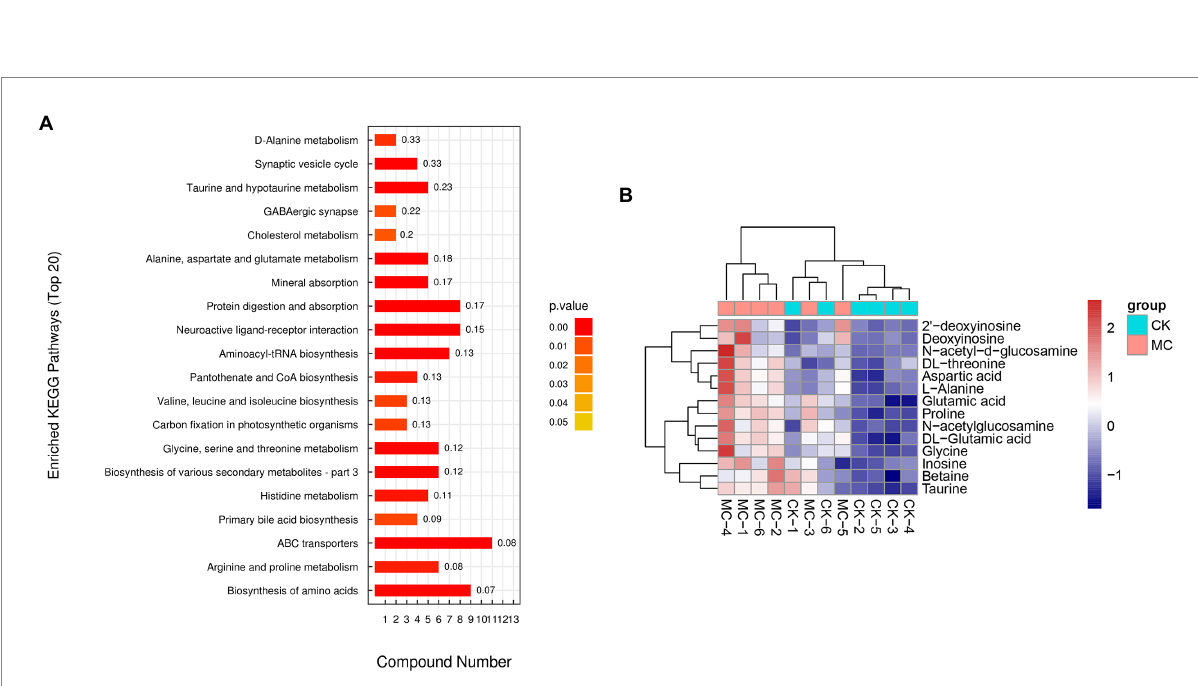
FIGURE 5 The pathways of differential metabolites in the intestinal of L . vannamei after MC-LR exposure. (A) The pathways of differential metabolites. (B) The differential metabolites of ABC